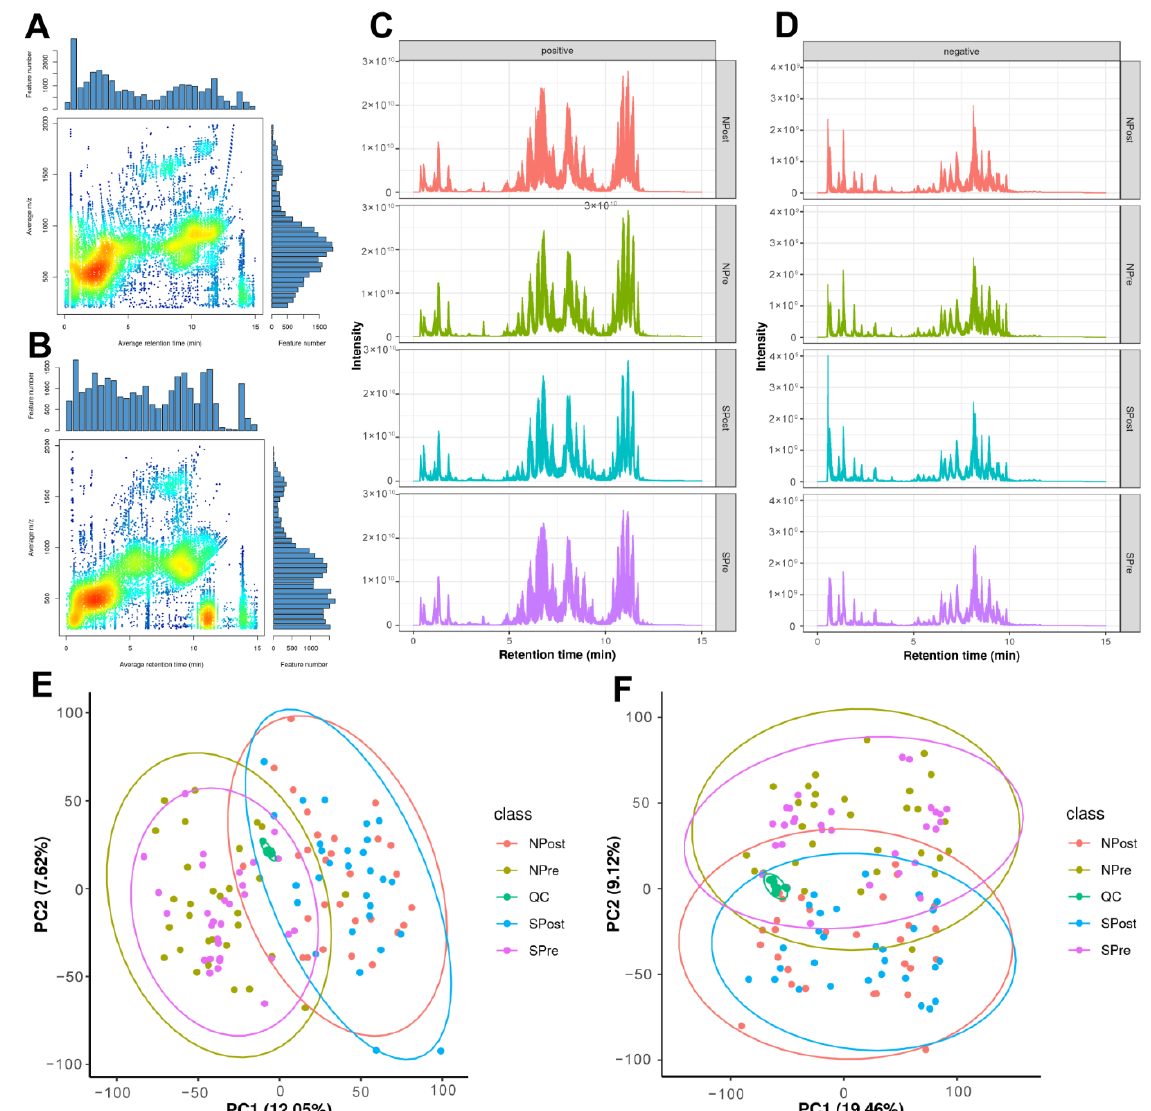
Figure 2. Overview of quantitative lipidomic data. The aligned feature distribution in positive mode ( A ) and in negative mode ( B ). Total ion chromatogram in positive mode ( C ) and in negative mode ( D ). Principal component analysis of all lipids in positive mode ( E ) and in negative mode ( F ). For the lipid identifications, there were 966 (positive mode) and 673 (negative mode)